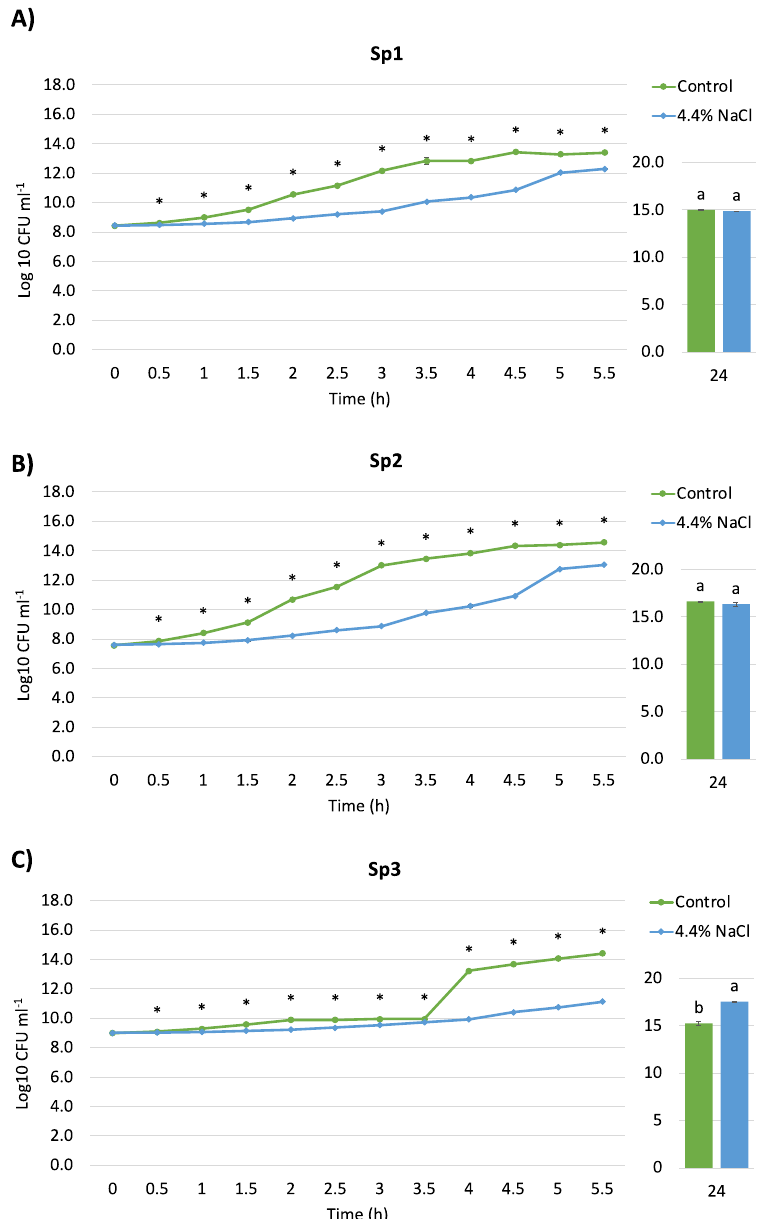
Figure 3. Growth curves of Serratia plymuthica strains. Effect induced by the treatment with 4.4% NaCl (light blue) compared to untreated cells (green) in the first 5.5 h and at 24 h of incubation (28 °C in shaking) on the growth (Log10 cfu/mL) of the different bacterial strains: ( A ) Serratia plymuthica Sp1; ( B ) S. plymuthica Sp2; ( C ) S. plymuthica Sp3. Asterisks and different letters indicate